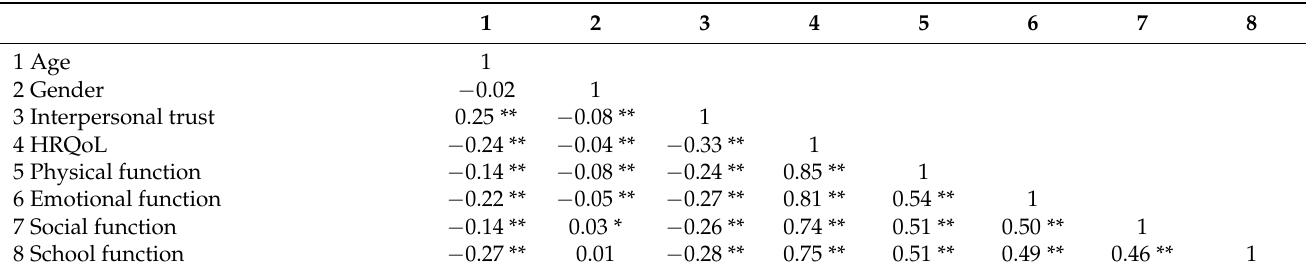
Table 3. Correlations between health-related quality of life and all variables.